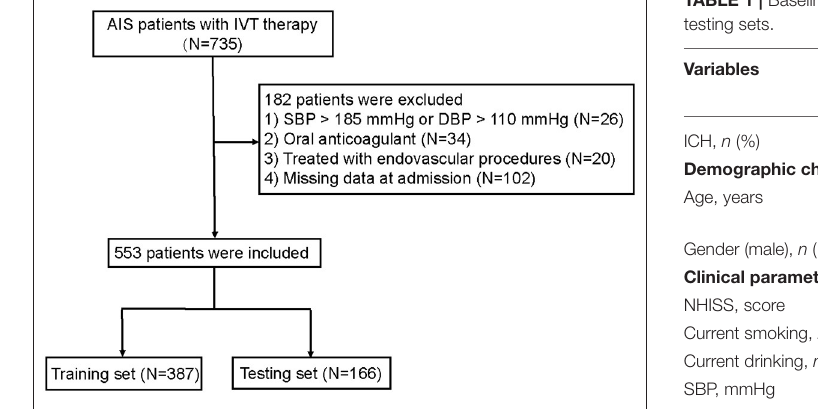
FIGURE 1 | Flow diagram of the selection of eligible patients. AIS, acute ischemic stroke; IVT, intravenous thrombolysis. SBP, systolic blood pressure; DBP, diastolic blood pressure.